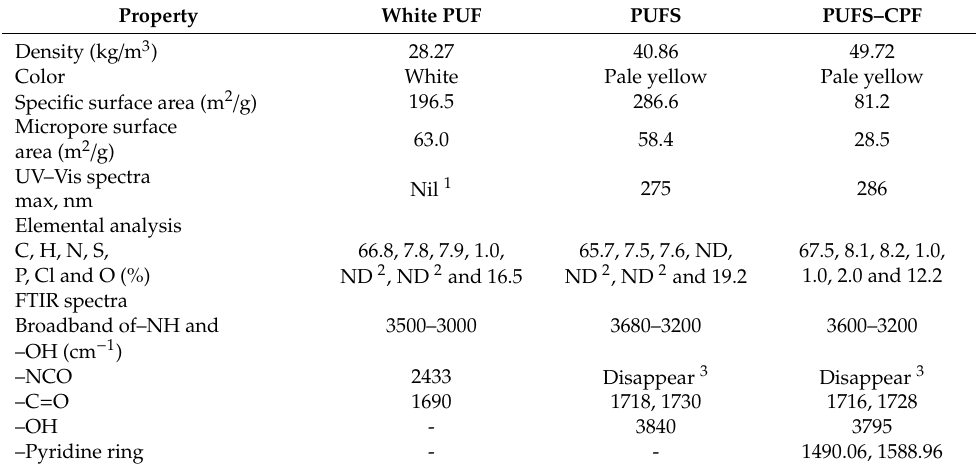
Table 2. Comparison between the Characterization of White-PUF, PUFS and PUFS–CPF.